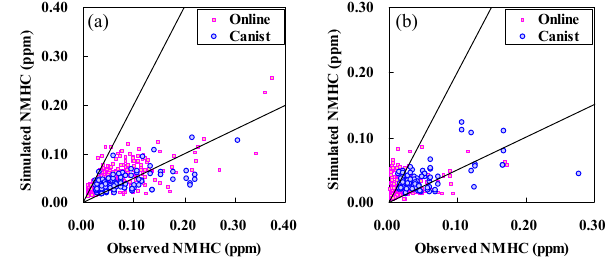
Fig. 5. Scatter plot of observed and simulated NHMC at (a) GDEMC and (b) Xinken. The 1:2 and 2:1 lines are also included.